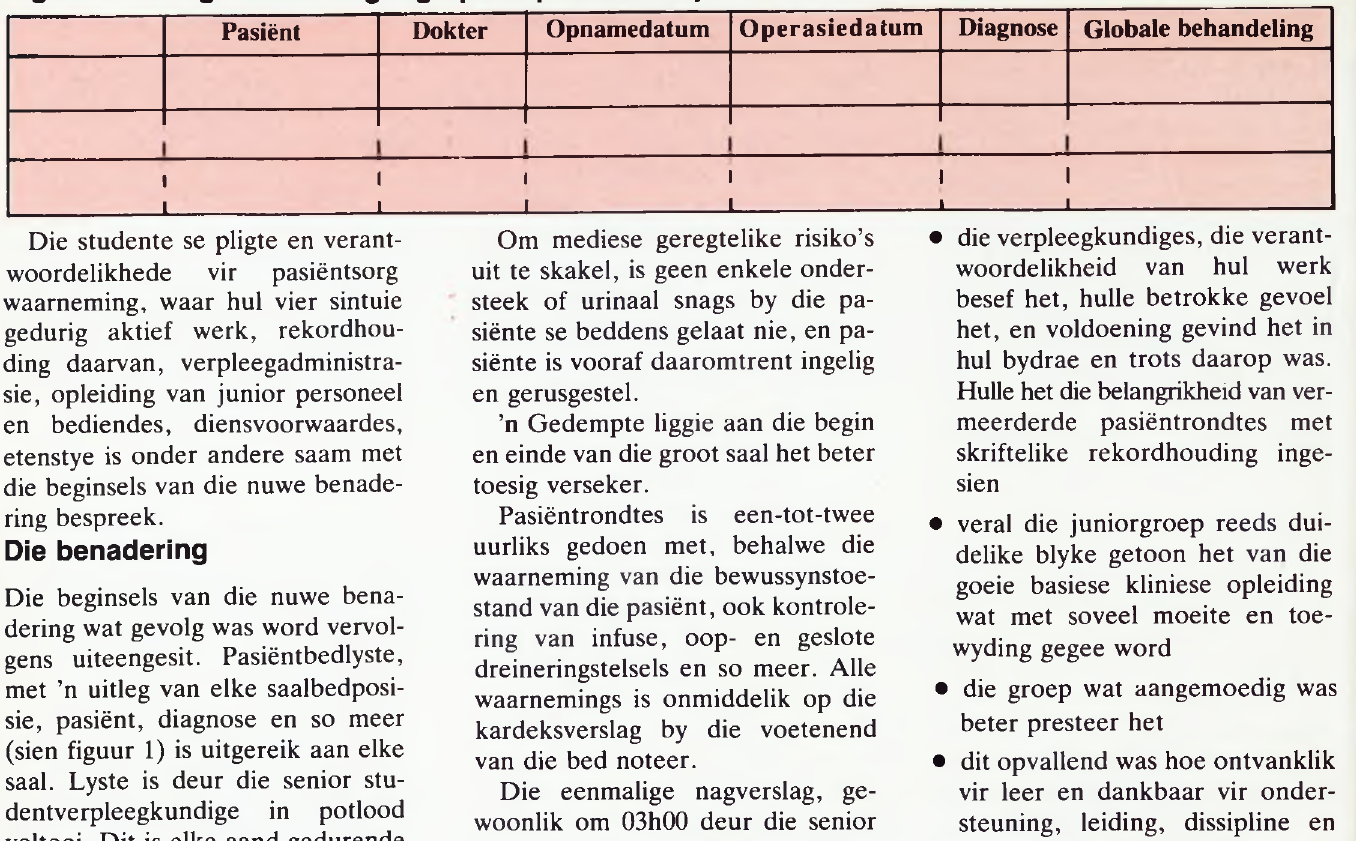
Figuur 1 Voorgestelde inligting op die